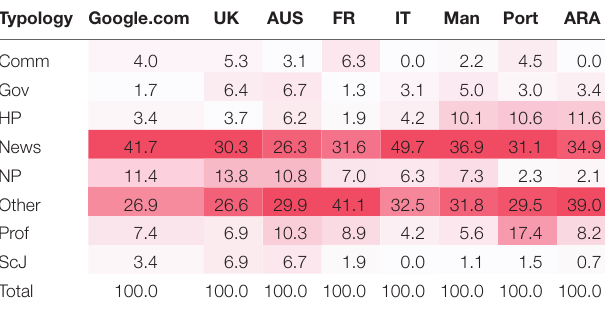
Table 4 | Composition of the top 10 webpages by typology. Typology google.com